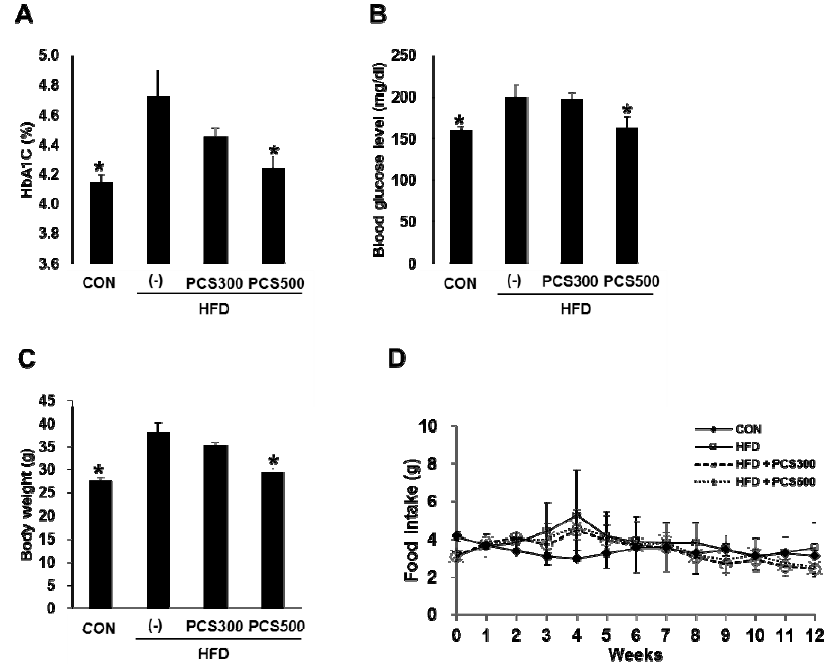
Figure 1. Effect of Psoralea corylifolia L. seed (PCS) extract on HbA1c, blood glucose and body weight gain in HFD-fed mice. Mice were fed with regular chow diet (CON) or HFD for 12 weeks. HFD-fed were treated with vehicle (-) or PCS extract (300 or 500 mg/kg/day) from the first day of HFD feeding ( n = 7–10/group). ( A ) HbA1c levels; ( B ) Blood glucose levels; and ( C ) body weight after 12 weeks of PCS extract treatment; ( D ) Food intake during 12 weeks of PCS extract treatment. *, p < 0.05 vs. vehicle-treated HFD-fed mice.